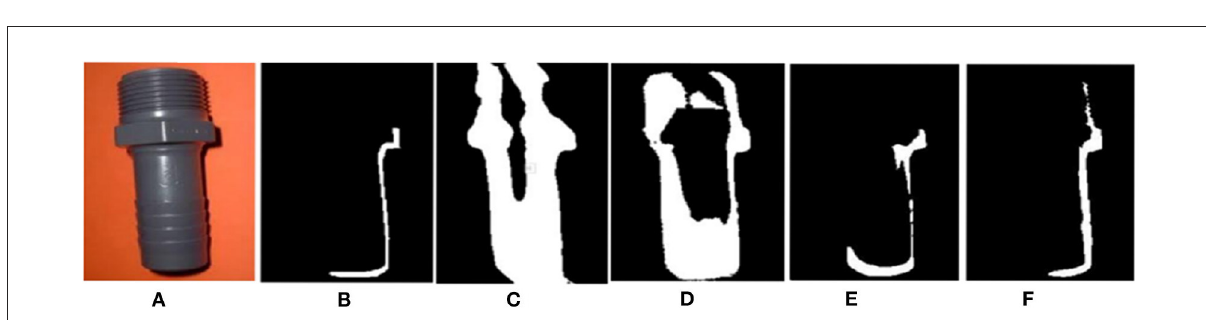
FIGURE10 Detection results with different methods on SBU dataset. (A) Shadow image, (B) GT, (C) GSCA-Unet, (D) SAS, (E) DSAN, and (F) proposed.